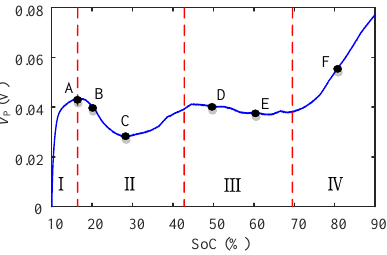
Figure 3. V P versus SoC under constant-current (CC) charging.